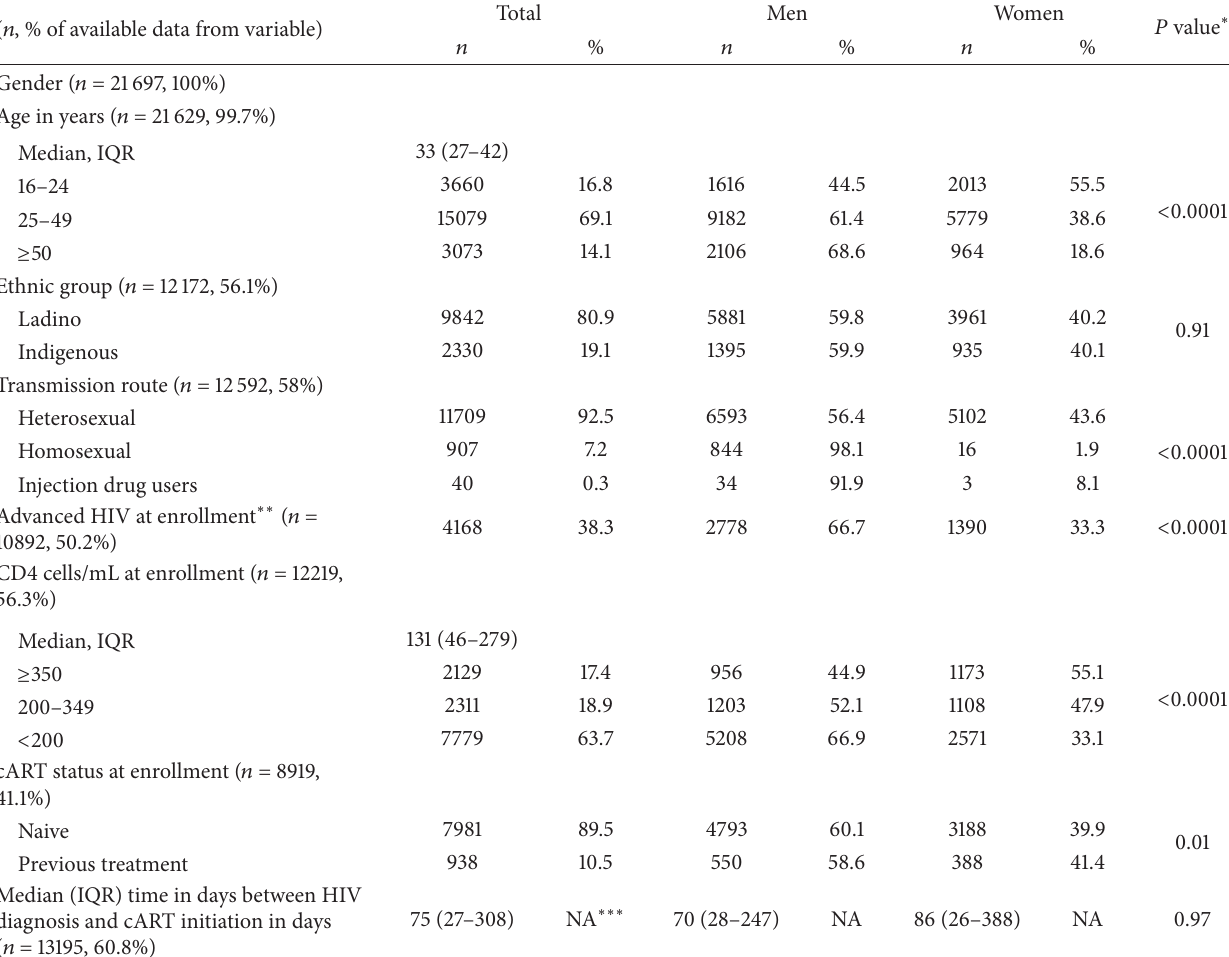
Table 2: Patient characteristics at enrollment in the MANGUA